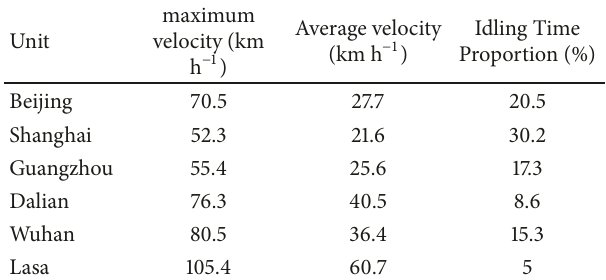
Table 5: Typical urban vehicle operating conditions in China. Unit